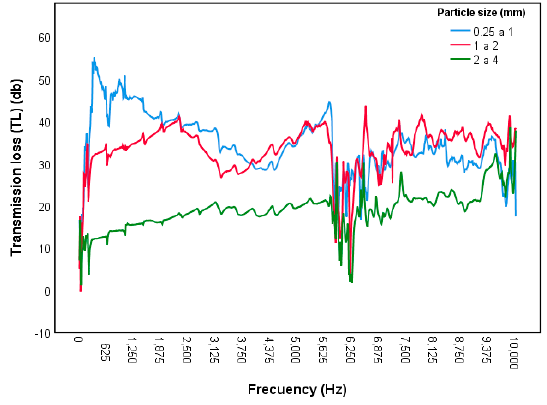
Figure 6. Transmission loss according to particle size.